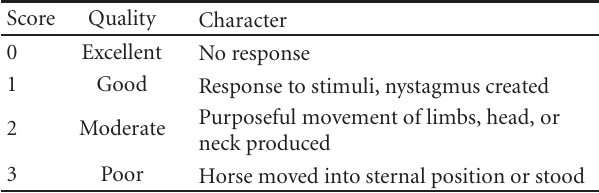
Table 2: Score card for quality of analgesia.